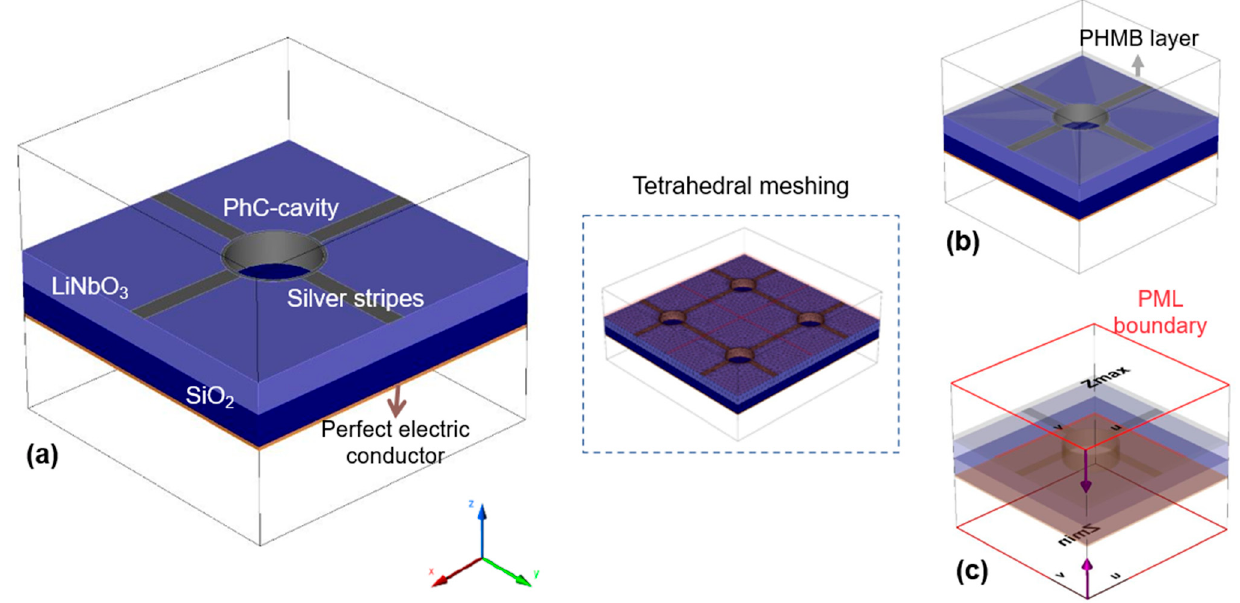
Figure 3. ( a ) Unit structure. ( b ) Unit structure with PHMB functional layer. ( c ) Unit structure signifying source, sink, and PML boundaries of the structure. Moreover, the structure enclosed in the (do tt ed) square represents the tetrahedral meshing technique for be tt er accuracy in the design process.